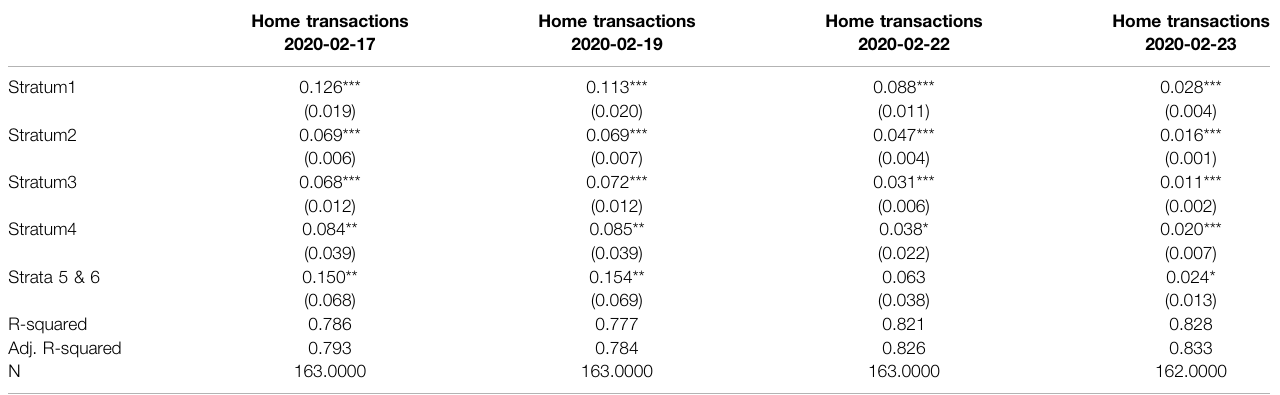
TABLE 1 | Sample OLS estimation for strata inference. Samples days are Monday, Wednesday, Saturday and